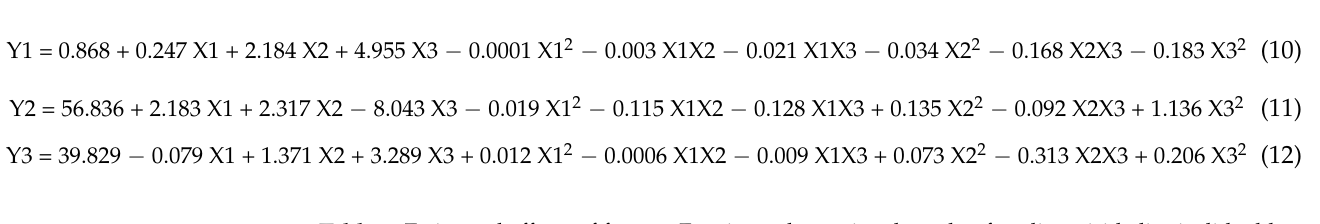
Table 6. Estimated effects of factors, F-ratio, and associated p -value for glimepiride liquisolid tablets on the angle of repose, hardness, and drug